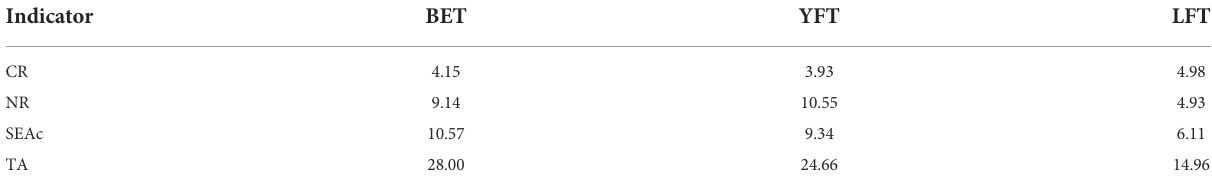
TABLE 5 Trophic structure parameters of three species of tuna: Thunnus obesus (BET), Thunnus albacores (YFT), and Thunnus alalunga (LFT). Indicator